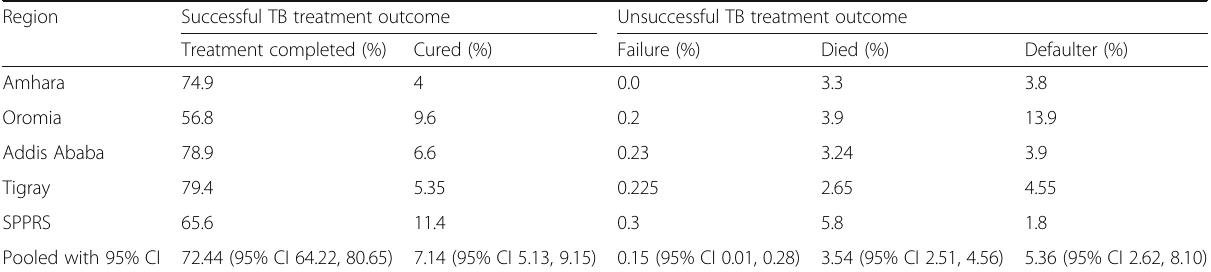
Table 2 Childhood tuberculosis treatment outcome Region Successful TB treatment outcome Unsuccessful TB treatment